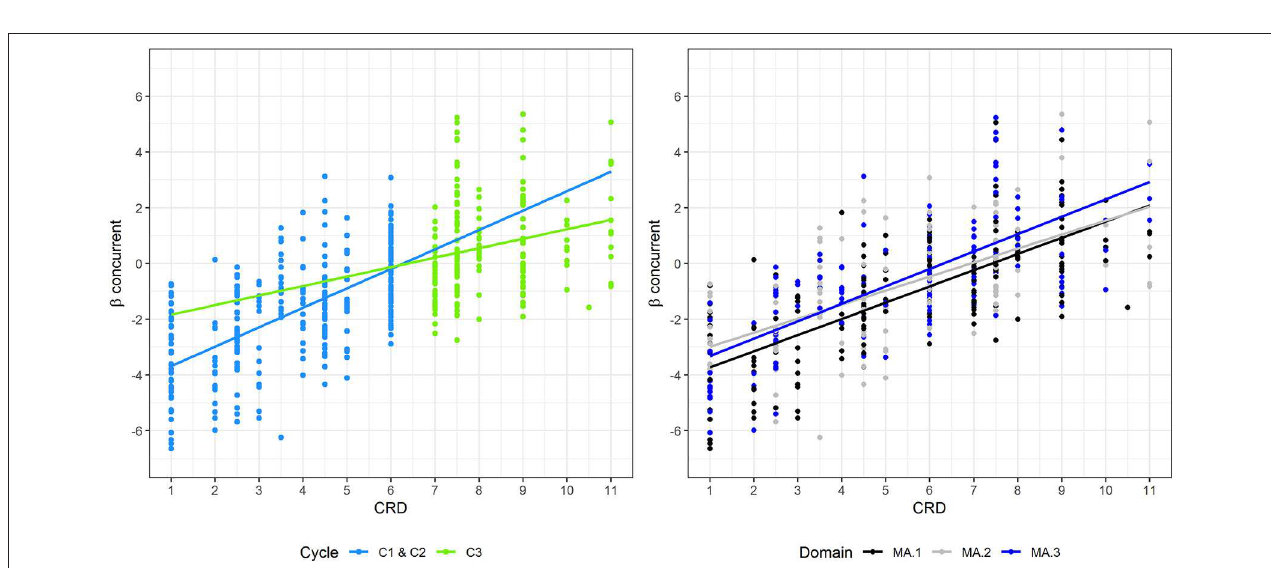
FIGURE 3 | Boxplots illustrating the distribution of difficulty estimates from the concurrent calibration for each CRD category. C1, C2, and C3 refer to cycles 1, 2, and 3, respectively.